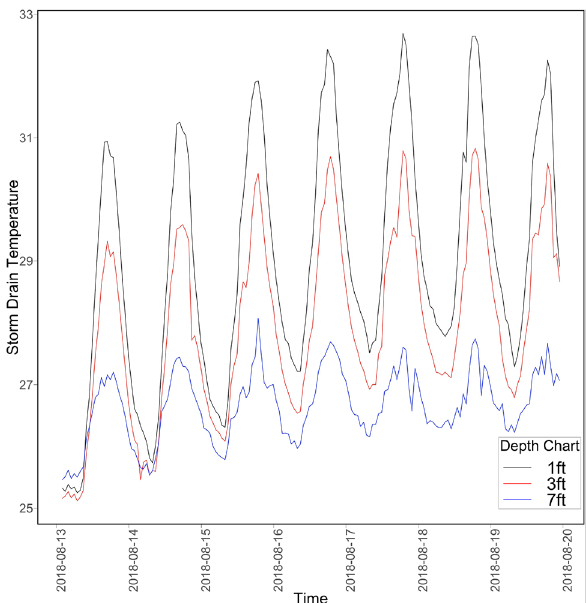
Figure 5. Storm drain temperature recorded at different depths.